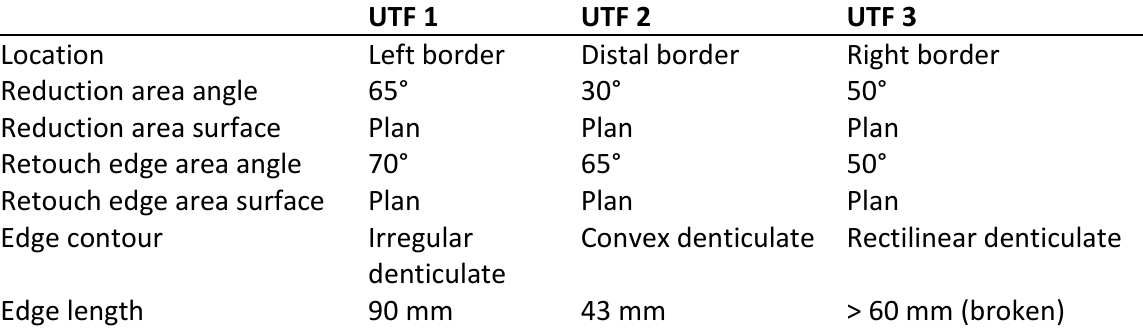
Table 3. Artifact transformative UTFs main features.